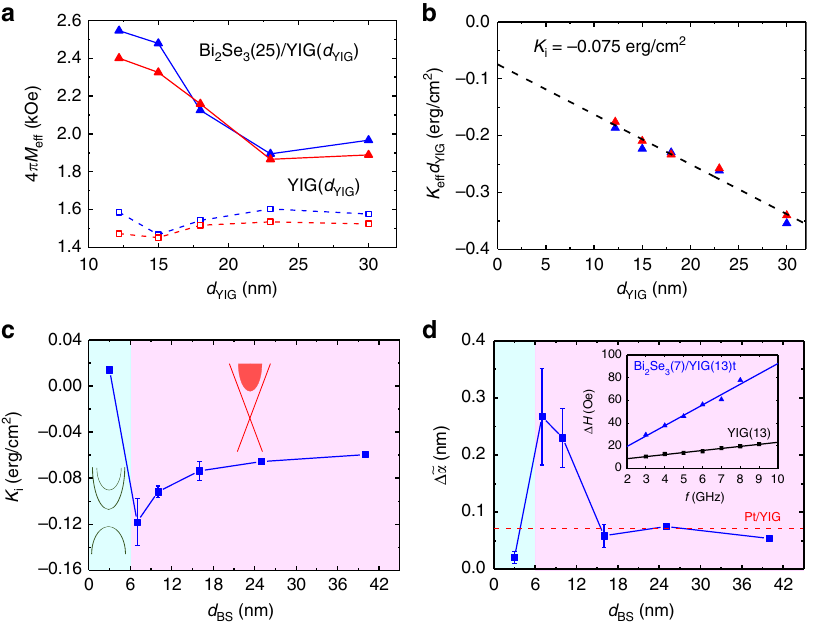
Fig. 2 YIG and Bi 2 Se 3 thickness dependence of FMR characteristics of Bi 2 Se 3 /YIG. a The d YIG dependence of 4 π M eff of Bi 2 Se 3 /YIG (solid triangles) and YIG (hollow squares) obtained from θ H (red) and f (blue) dependent FMR. b The K eff d YIG vs. d YIG plot for determining K i using a linear fi t. The intercept of the y - axis corresponds to the K i value. c d BS dependence of K i . The fi gure is divided into two regions. For d BS > 6 nm, the Dirac cone of TSS is intact, with the Fermi level located in the bulk conduction band. For d BS < 6 nm, a gap and quantum well states form. d The d BS dependence of normalized damping enhancement Δ ~ α . The inset shows Δ H as a function of f Bi α − α Δ ~ α of 2 Se 3 (7)/YIG(13) and YIG(13) for calculating BS/YIG YIG . The red dashed line shows the typical value of Pt/YIG for comparison. The error bars indicate standard deviations of at least four